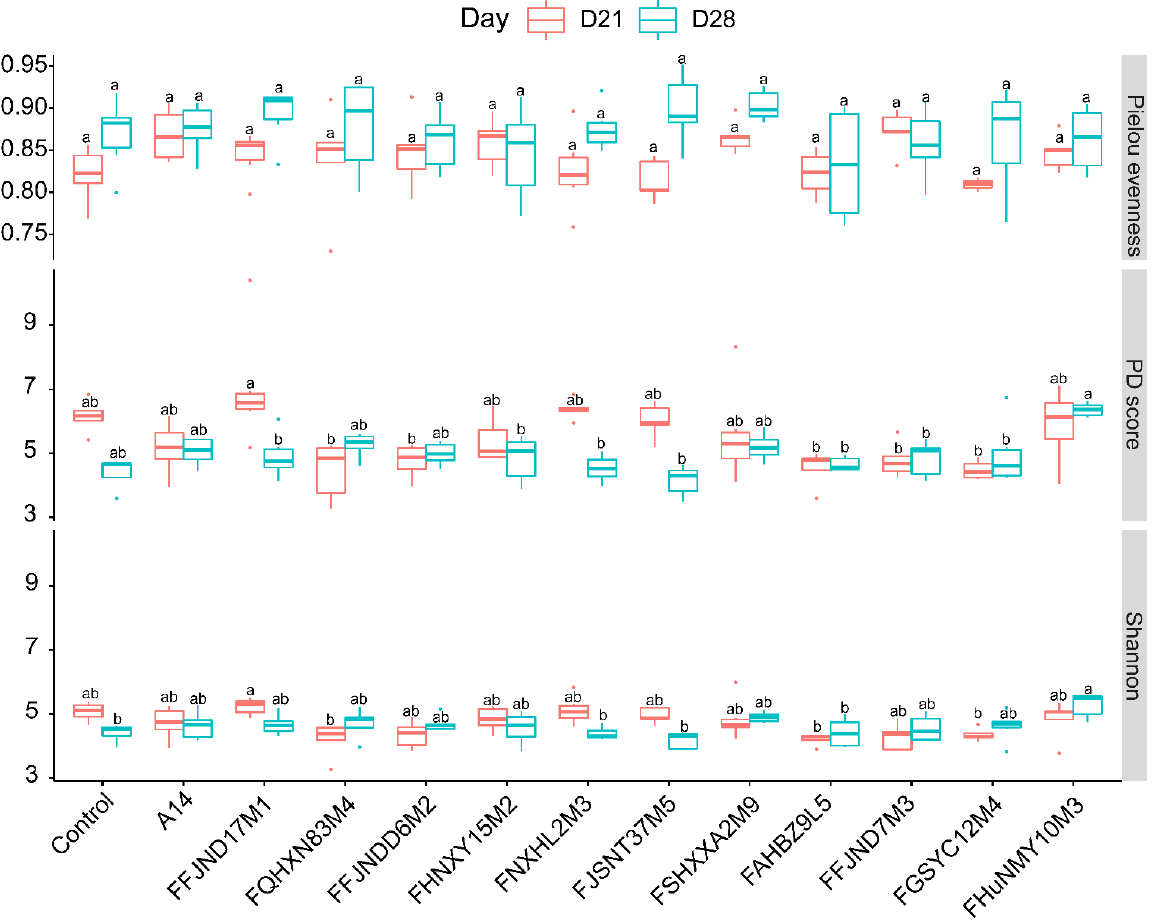
Figure 7. Alpha diversity indexes of gut microbiota in different mice group at different time points (red: 21 days, green: 28 days). Different lowercase letters mean that there is a statistically significant difference between 13 groups at a probability level of p < 0.05 .